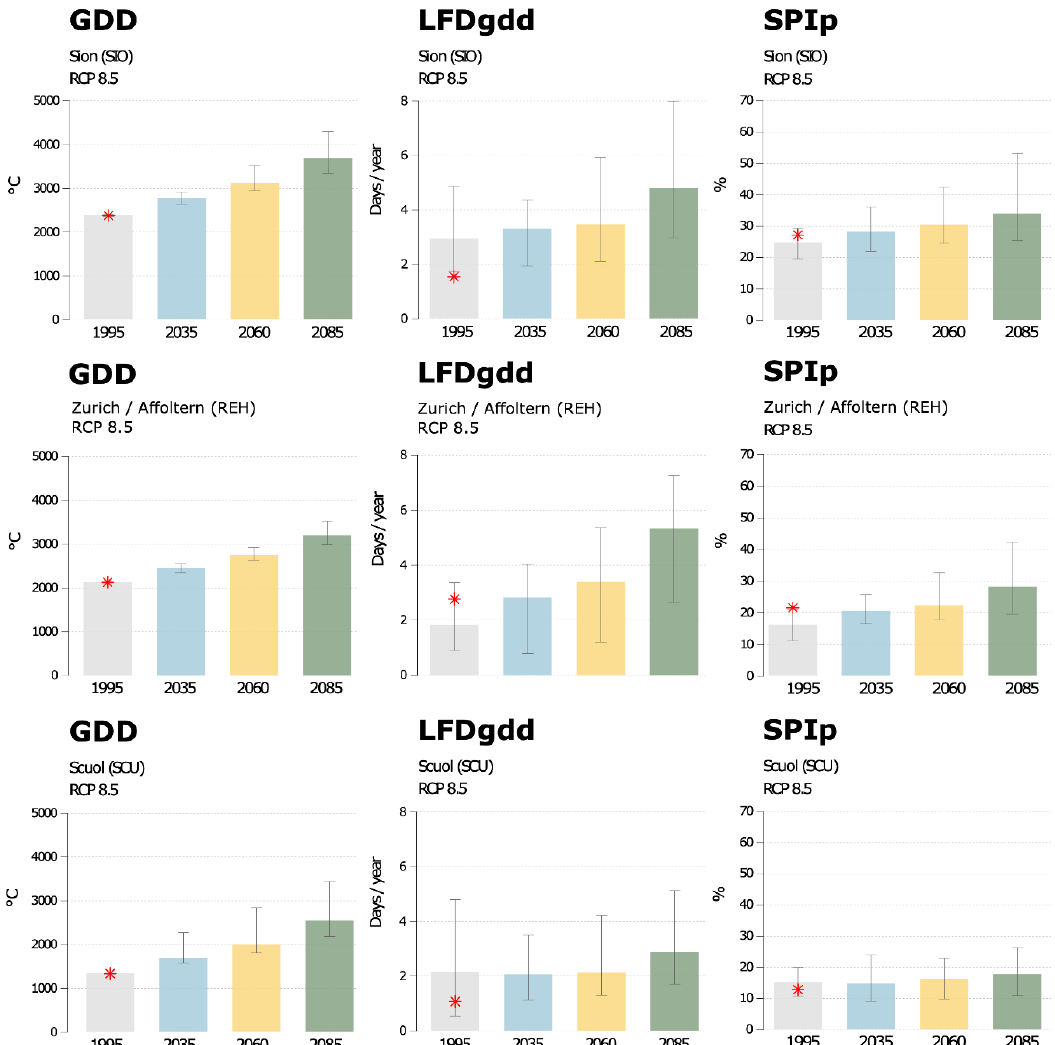
Figure 6. Median values for three selected indices (GDD, LFDgdd and SPIp) for all four periods considered and for the three exemplary stations of Sion (SIO; upper row ), Zurich/Affoltern (REH; middle row ) and Scuol (SCU; lower row ). The red stars refer to the observed value in the reference period. The grey bar (1995) indicates the median values of the quantile-mapped scenario data in the historical reference period. The blue (2035), yellow (2060) and green (2085) bars, respectively, represent future periods assuming the RCP8.5 emission scenario. The whiskers are showing the 5 th and 95 th quantile.